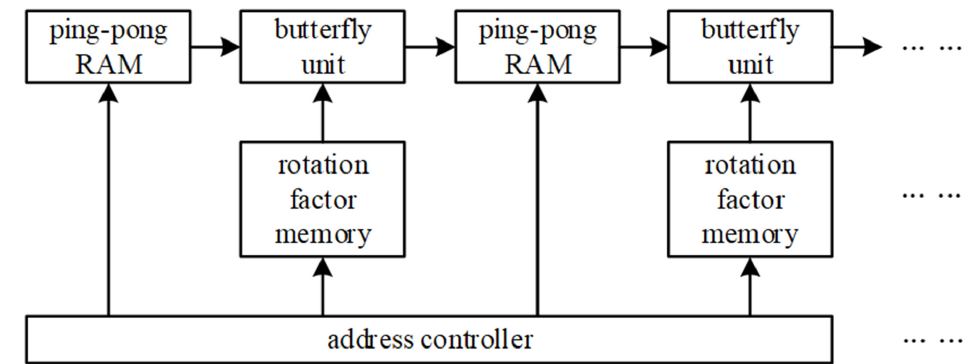
Figure 3. Architecture diagram of the cascade structure.